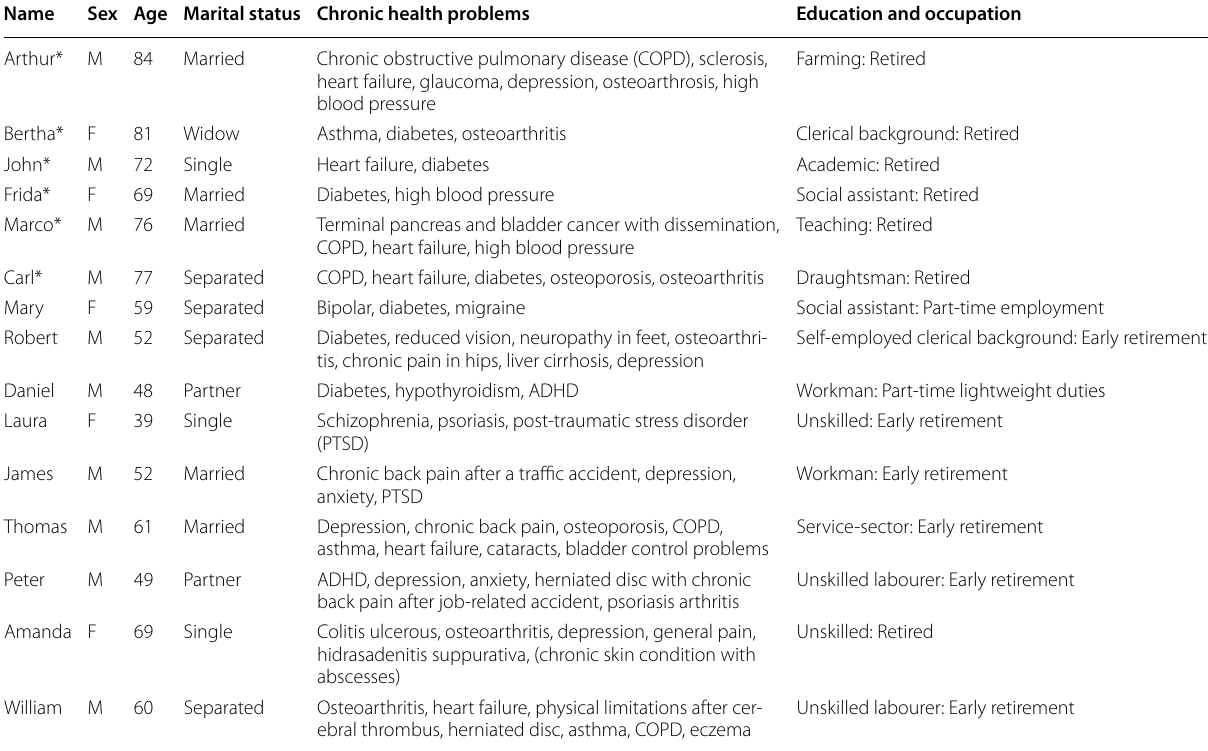
Table 1 Characteristics of informants–characteristics are altered to secure